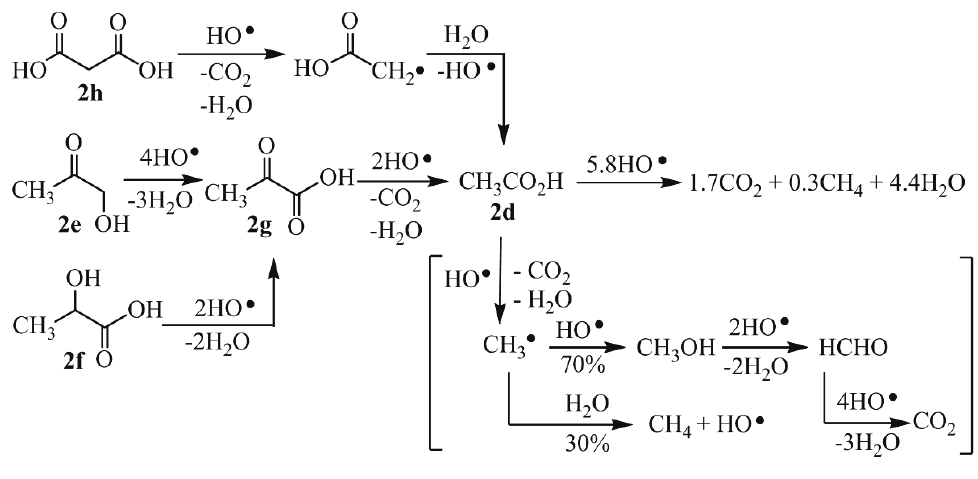
Figure 3. Decomposition of carboxylic acid ( 2d – h ) by HO • radical.